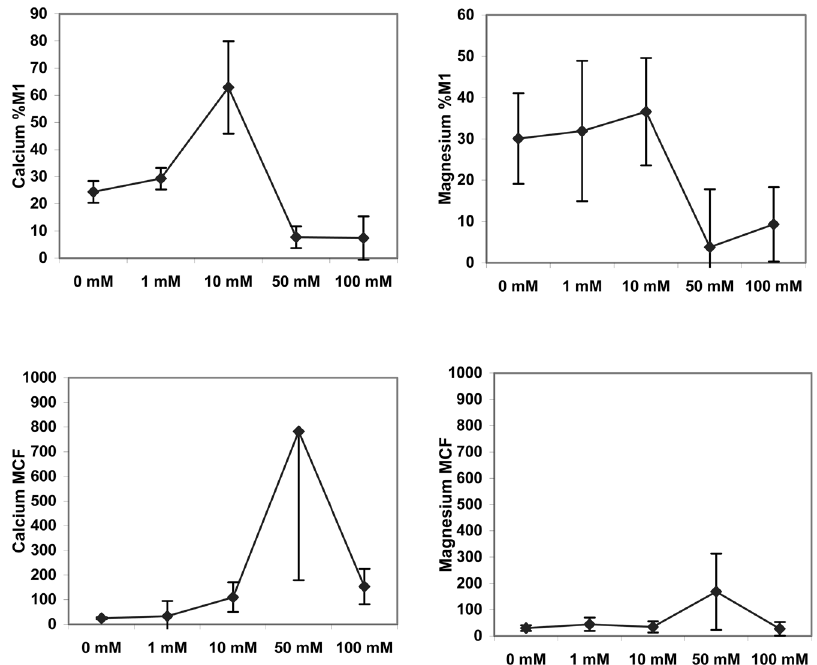
Figure 3. Effect of divalent cations on microsphere binding. Bead-binding assays were performed in sterile water with varying concentrations of Ca ++ (CaCl2) or Mg ++ (MgSO4). The percentage of yeast cells showing fluorescence (% M1) is presented in the upper panels. Data are for 12 clinical yeast isolates, and standard deviation is shown by error bars. The relative fluorescence (MCF-Fl3-h) is shown in lower panels. Both parameters indicate that divalent cations reduced microsphere binding compared with controls.